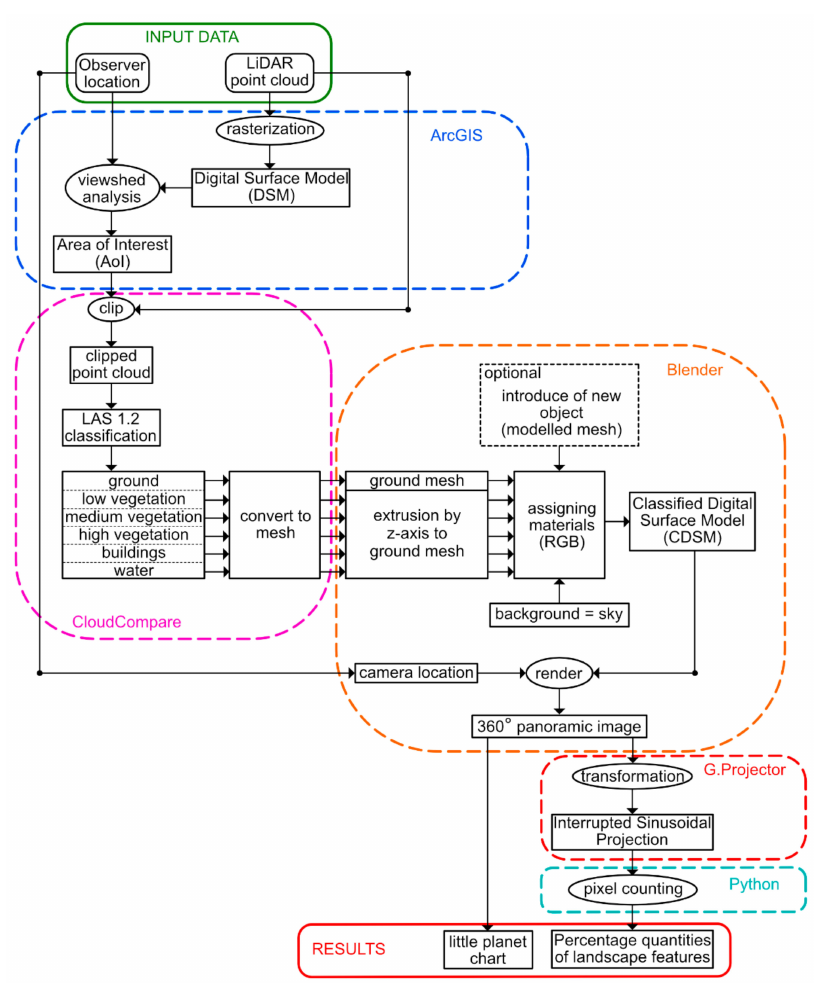
Figure 1. Proposed workflow